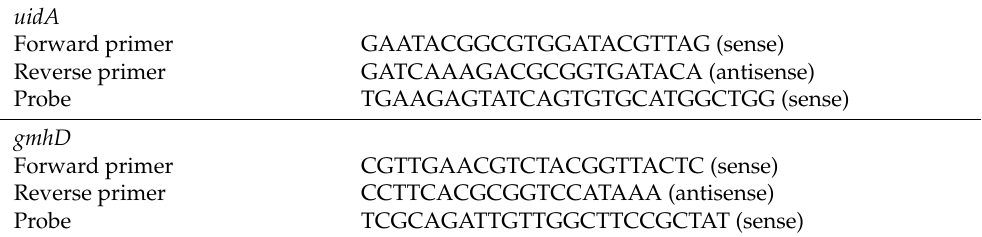
Table 1. Primer and probe sequences used to amplify uidA and gmhD sequences for qPCR analyses.